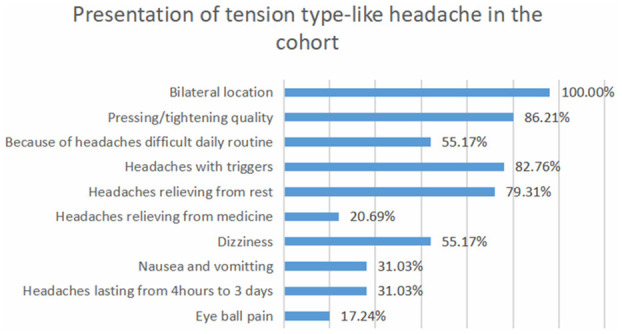
Presentation of tension-type-like headache in the cohort.